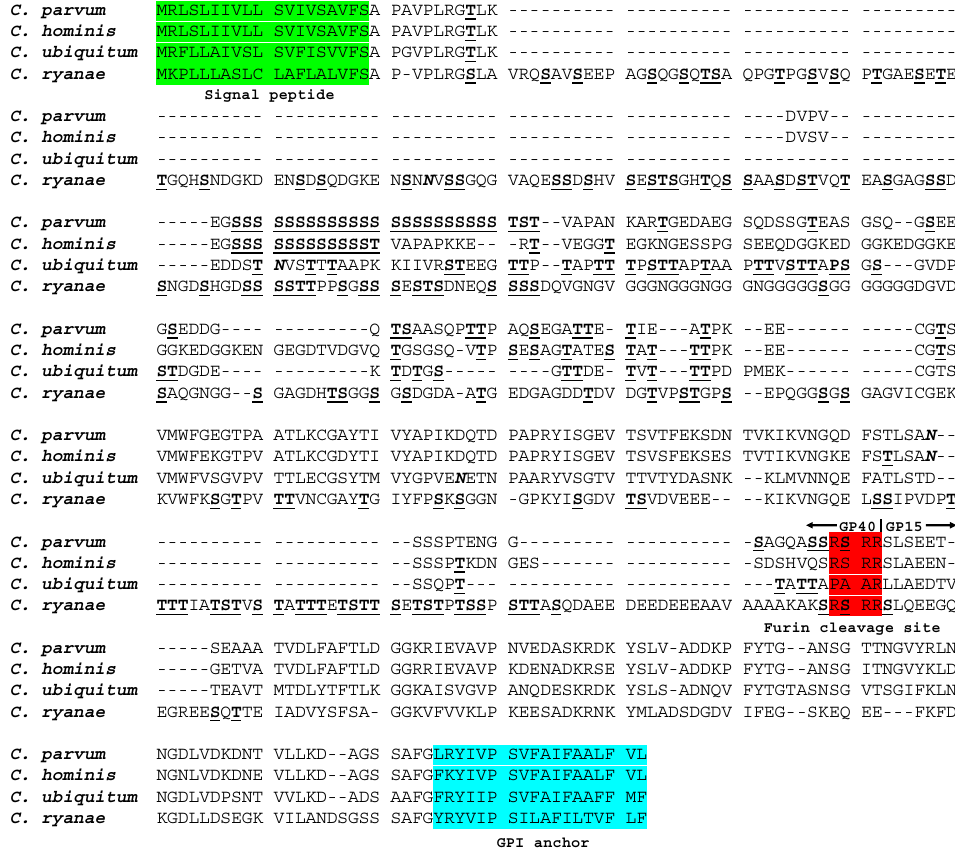
Figure 1. Deduced amino acid sequence of the gp60 gene of Cryptosporidium ryanae (45,019) compared with sequences of C. parvum (AF022929), C. hominis (FJ839883), and C. ubiquitum [10]. Potential N-linked glycosylation sites are indicated in boldface and italic type, and predicted O-linked glycosylation sites are indicated in boldface and underlined type. The first 19 amino acids for the signal peptide and the last 17 amino acids for the GPI anchor are highlighted in green and blue, respectively. The classic furin proteolytic cleavage site sequence RSRR is highlighted in red. Dashes denote amino acid deletions.